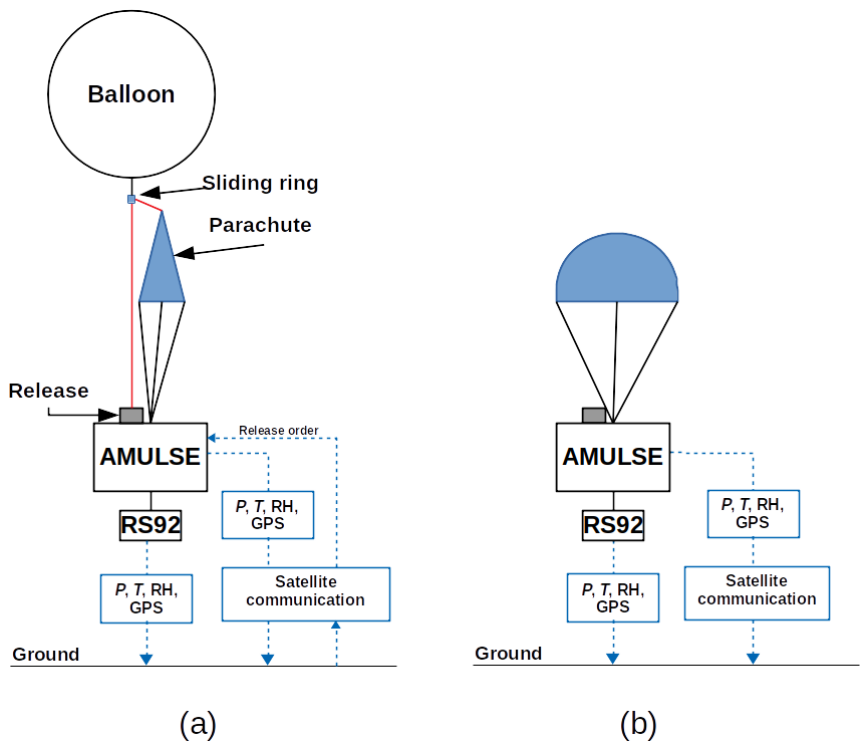
Figure 3. A schematic diagram of the flight chain during (a) ascent and (b) descent. Transmission and reception of the information during the flight is performed using both satellite and radio communications. A Vaisala RS92 in situ sounding system is connected, which measures and transmits instantaneous P , T , relative humidity and GPS data to a ground mobile station to inject those data in the trajectory model and hence ensure the tracking and recovery of the instrument. Note that the trigger release system can be controlled by either a homemade smartphone application or a web application using an iridium satellite communication system. These applications can also track the AMULSE position as the AMULSE instrument transmits its GPS position, pressure and temperature data every 5min ensuring a redundant retrieval